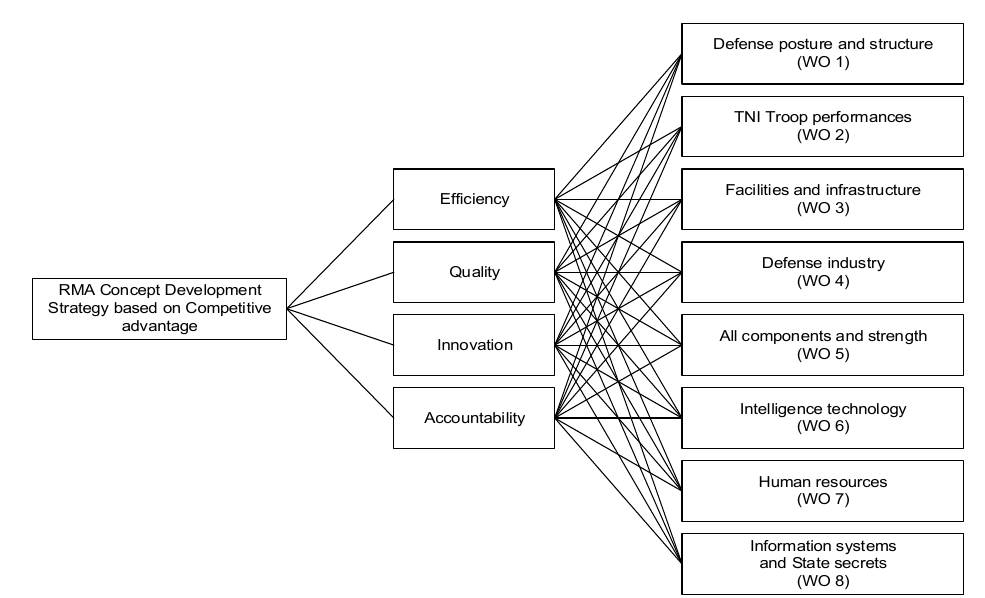
Fig. 5. AHP Hierarchy Scheme of TNI Strategy in